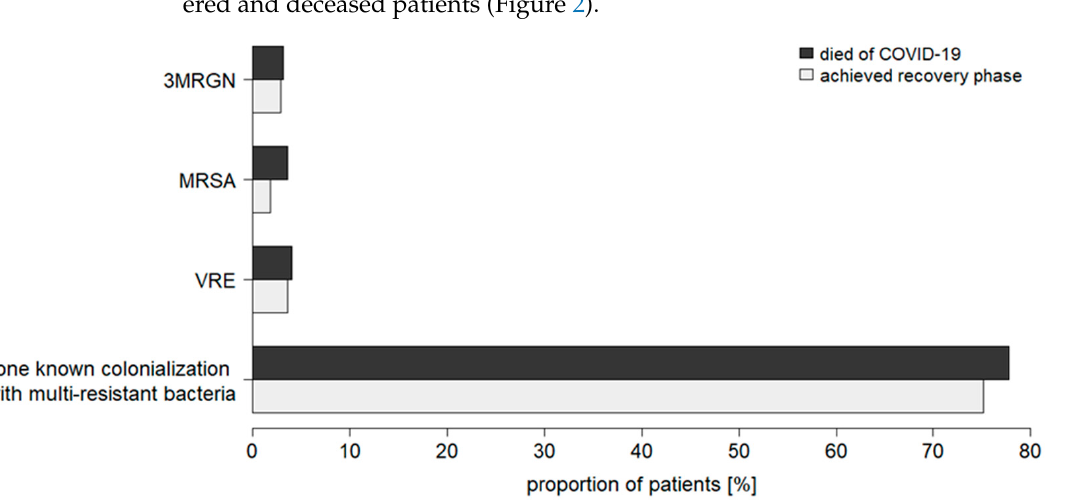
Figure 2. Prevalence of community-acquired colonializations with multidrug-resistant bacteria in recovered and deceased patients critically ill with COVID-19 (total cohort). MRGN: multidrug- resistant Gram-negative bacteria; MRSA: methicillin-resistant Staphylococcus aureus ; VRE: vancomycin- resistant